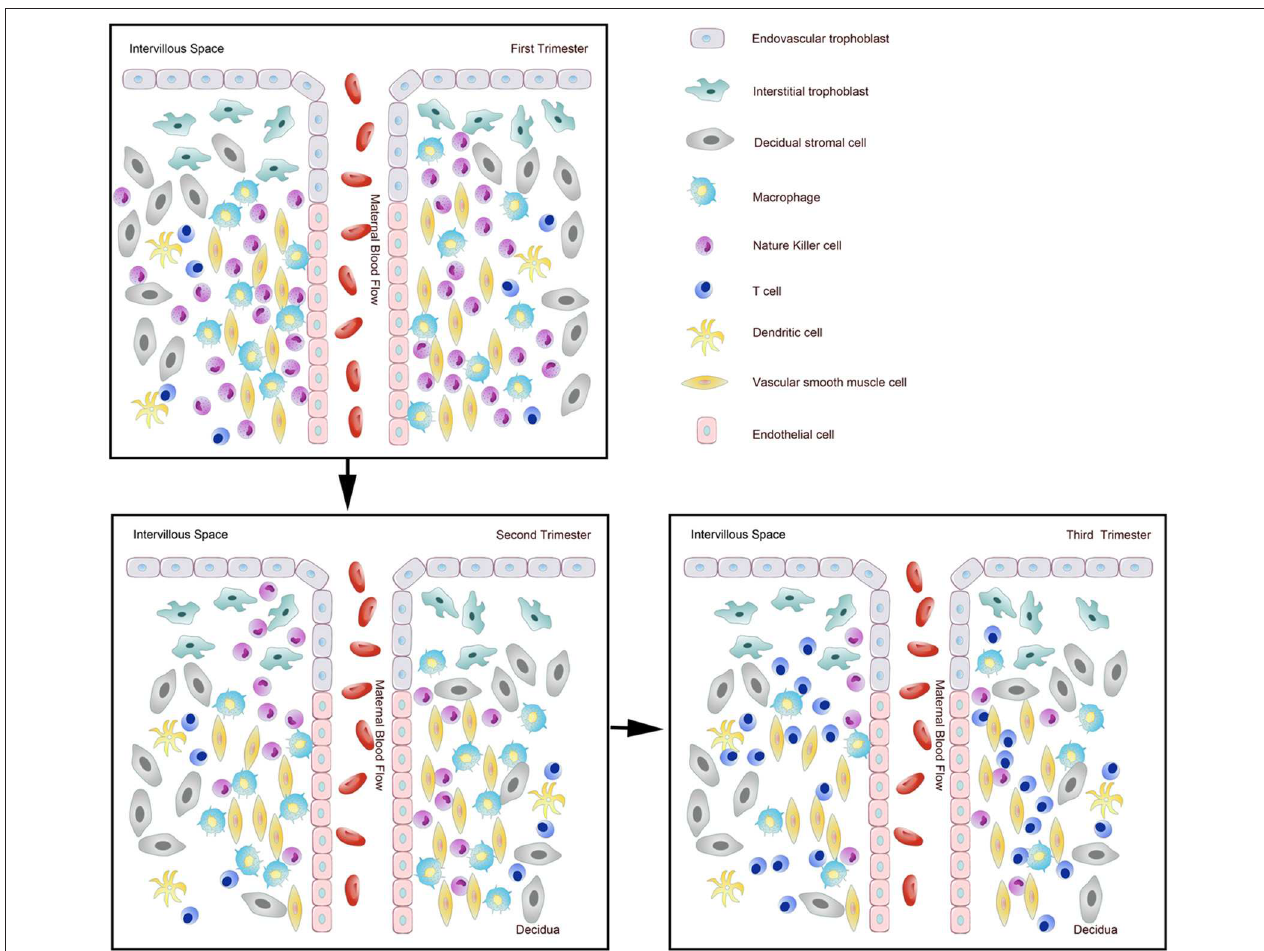
FIGURE 1 | Dynamic changes of immune cells during normal pregnancy at the maternal-fetal interface. Pattern diagram showed the dynamic changes of immune cells at the maternal-fetal interface.